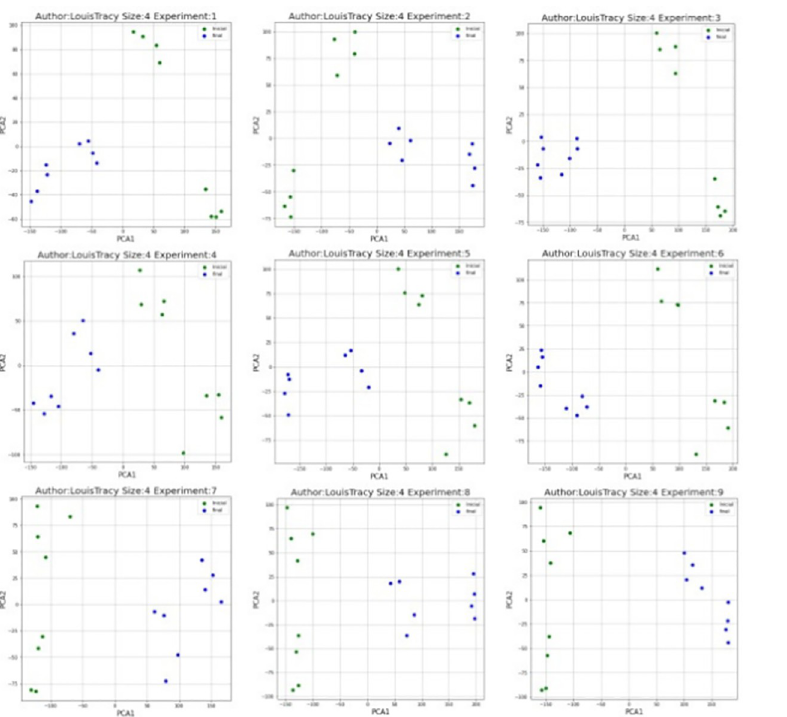
Fig 12. PCA visualization of Louis Tracy (LT) using syntactic relationship 3-gram.